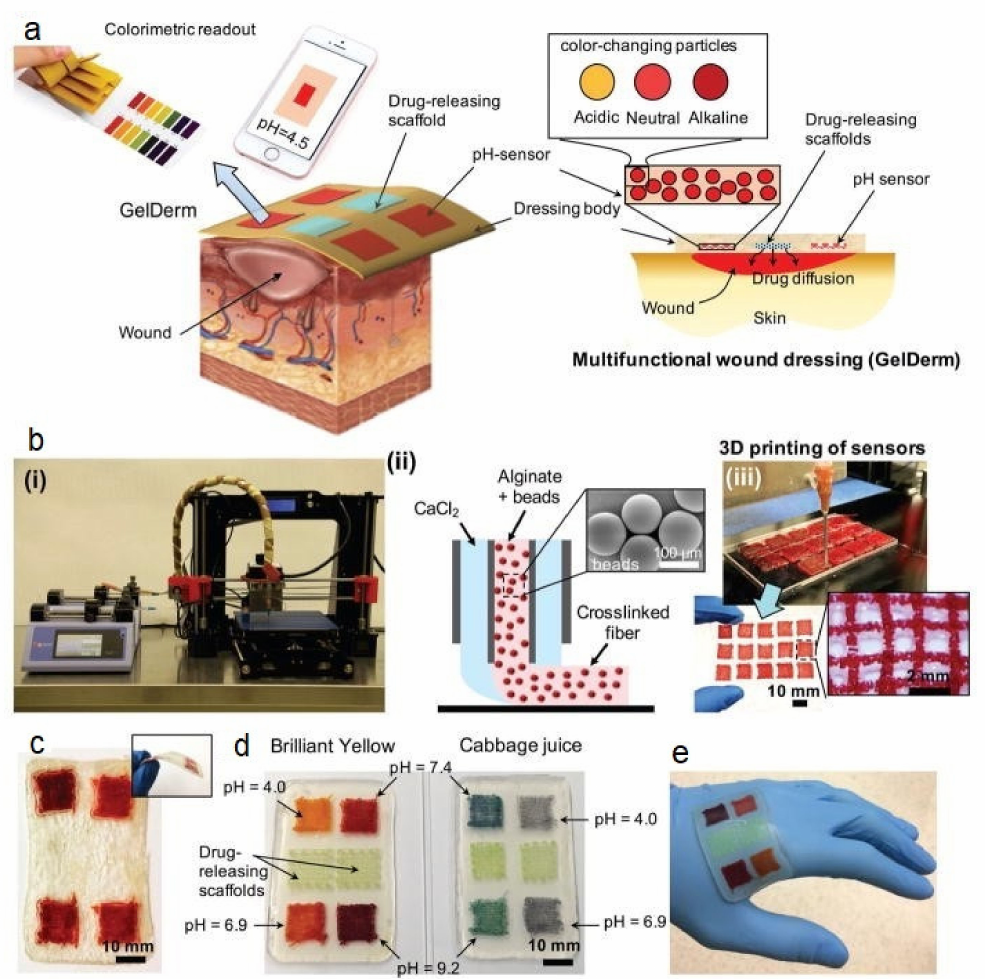
Figure 6. GelDerm is a sophisticated multipurpose dressing for wound monitoring and